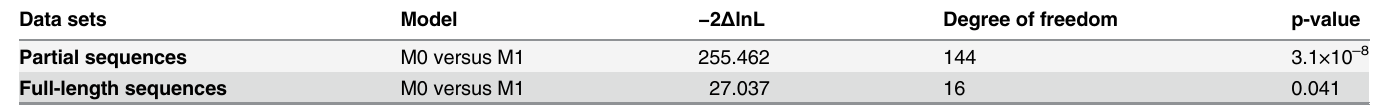
Table 3. Likelihood ratio test (LRT) stasticts for models of variable selective pressure among branches. Data